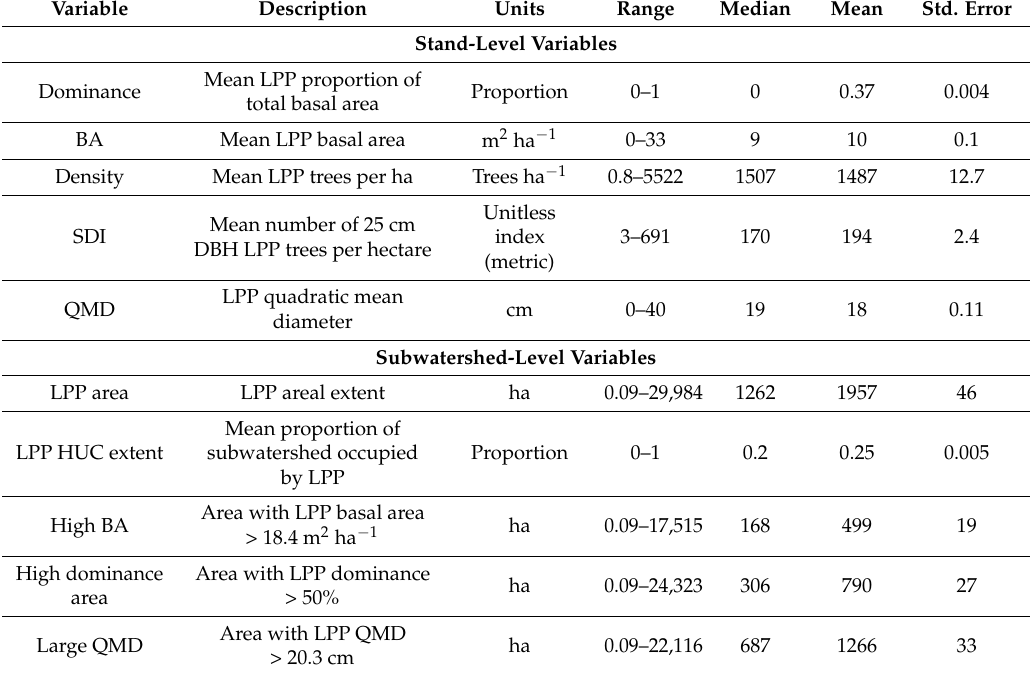
Table 1. Summary statistics for mean host characteristics and summed acreages by subwatershed ( n = 2226). LPP = lodgepole pine; BA = basal area; SDI = stand density index; DBH = diameter at breast height; QMD = quadratic mean diameter; HUC = hydrological unit